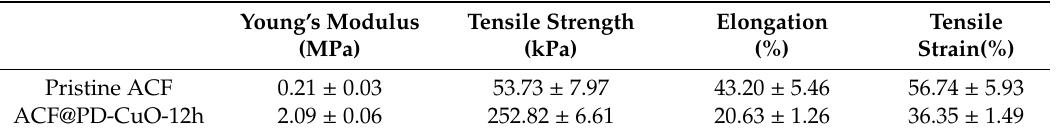
Figure 9. Stress-strain curve of pristine activated carbon fibers (ACF) and ACF@polydopamine-cupric oxide (PD-CuO)-12h. Table 1. Physical properties of pristine activated carbon fibers (ACF) and ACF@polydopamine-cupric oxide (PD-CuO). All the values are averages of 3